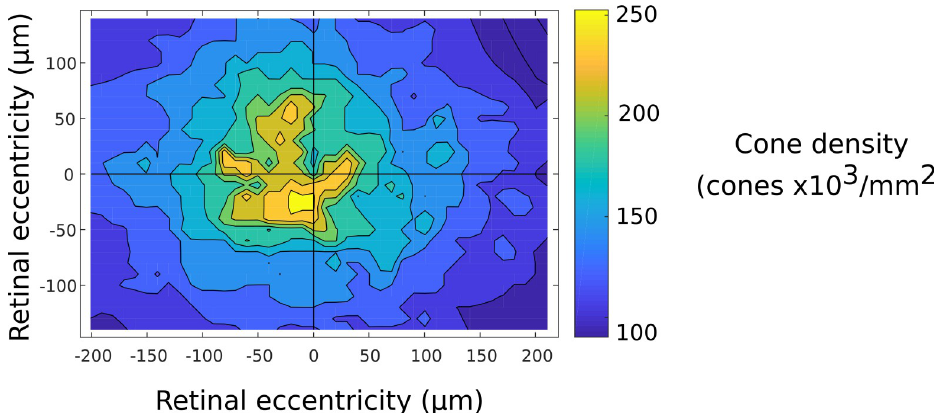
Fig 6. Cone isodensity plot for the same eye used for functional recording. Cone densities calculated using automatic cone identification [18] and nearest neighbor distances. The contour plot was generated by interpolating between averages of 30 μ m x 30 μ m squares sampled every 10 μ m in a square array. Contours are separated by 18,200 cones per mm 2 . The physiological foveal center is located at the origin with nasal and inferior directions corresponding to negative numbers. The majority of physiological recordings were made in a 200 μ m x 200 μ m region centered on the origin.